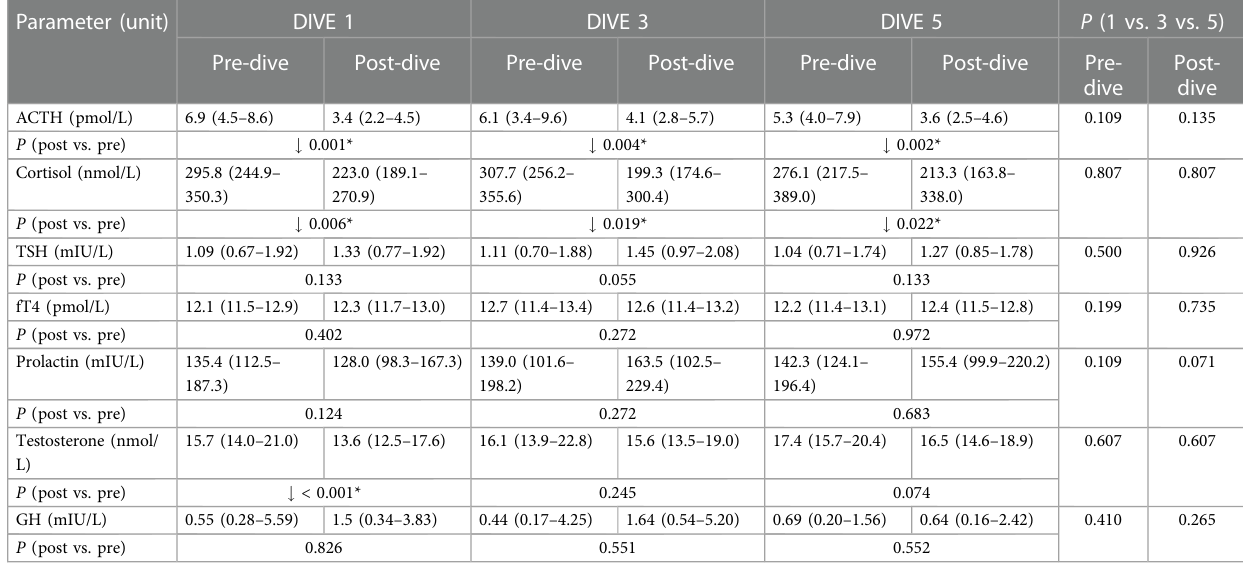
TABLE 1 Results of pituitary-target organ axis hormones levels before and after the fi rst, third, and fi fth dive. Parameter